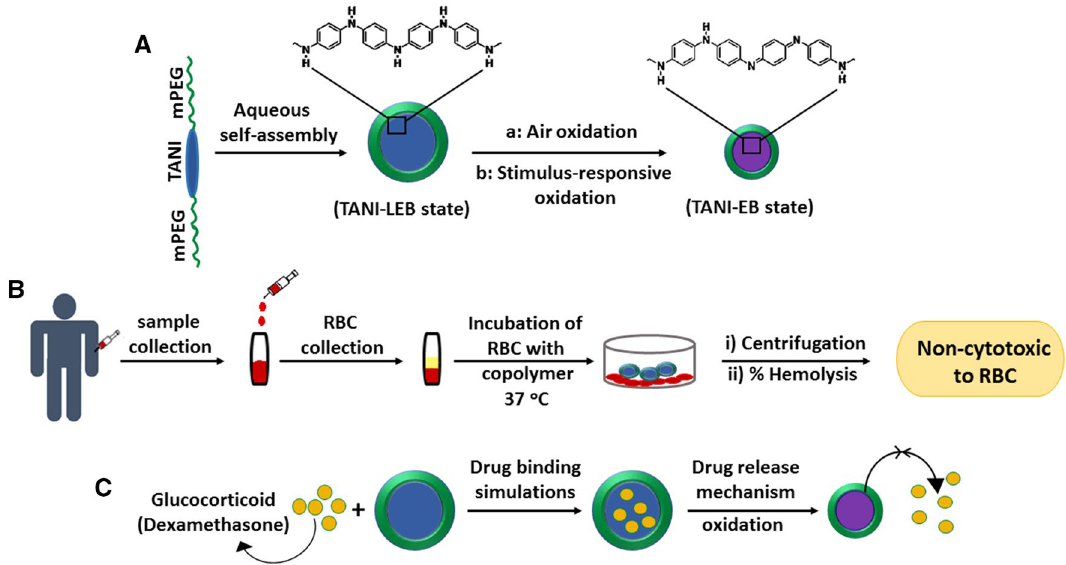
Figure 13. Synthesis, testing cytotoxicity, drug encapsulation (uptake/release), and computational analysis of triblock copolymer P2L. ( A ) Tunable aqueous self-assembly of the synthesized ABA-type triblock copolymer P2L. ( B ) Cytotoxicity analysis of copolymer P2L in the human blood samples under in vitro conditions. ( C ) Experimental and computational studies show the binding and potential delivery/release of dexamethasone by using copolymer